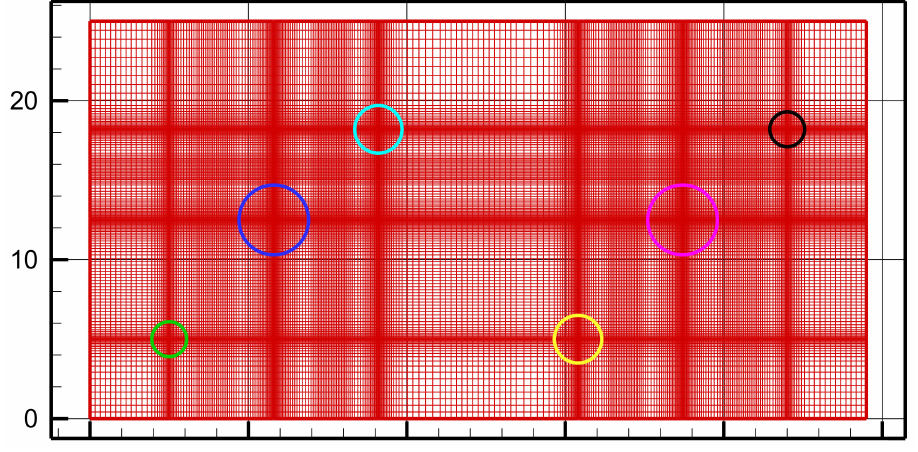
Figure 13. Horizontal view of the computational grid in the { x , y } plane for Building I.